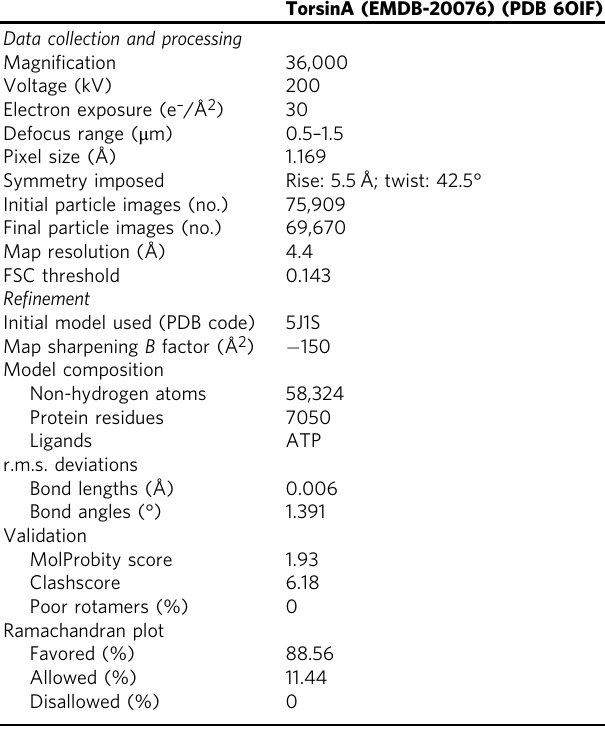
Table 1 Cryo-EM data collection, re fi nement, and validation statistics Data collection and processing Magni fi